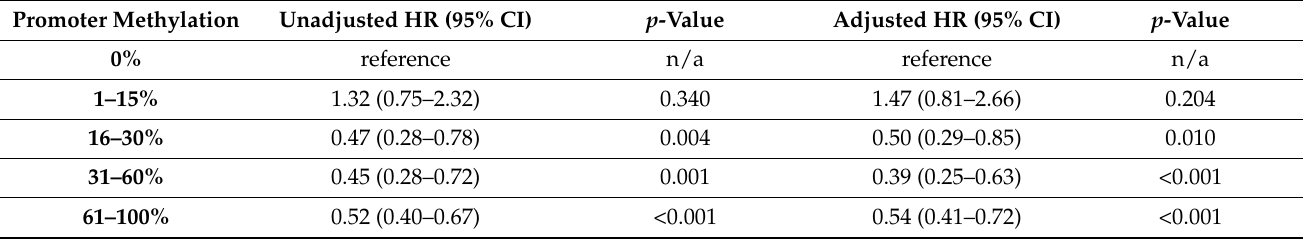
Table 2. Survival according to quantitative MGMT promoter methylation status.